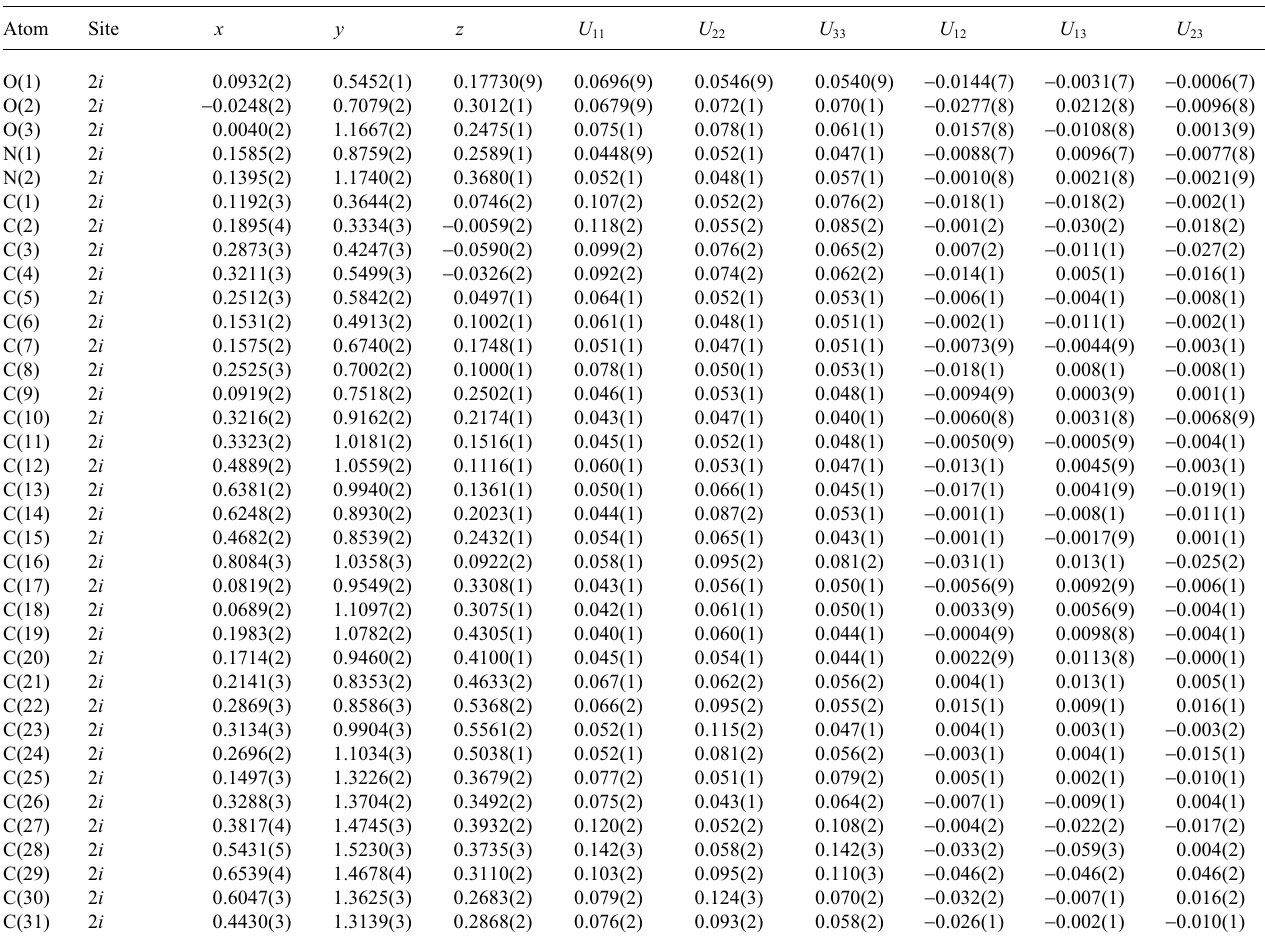
Table 3. Atomic coordinates and displacement parameters (in Å 2 )